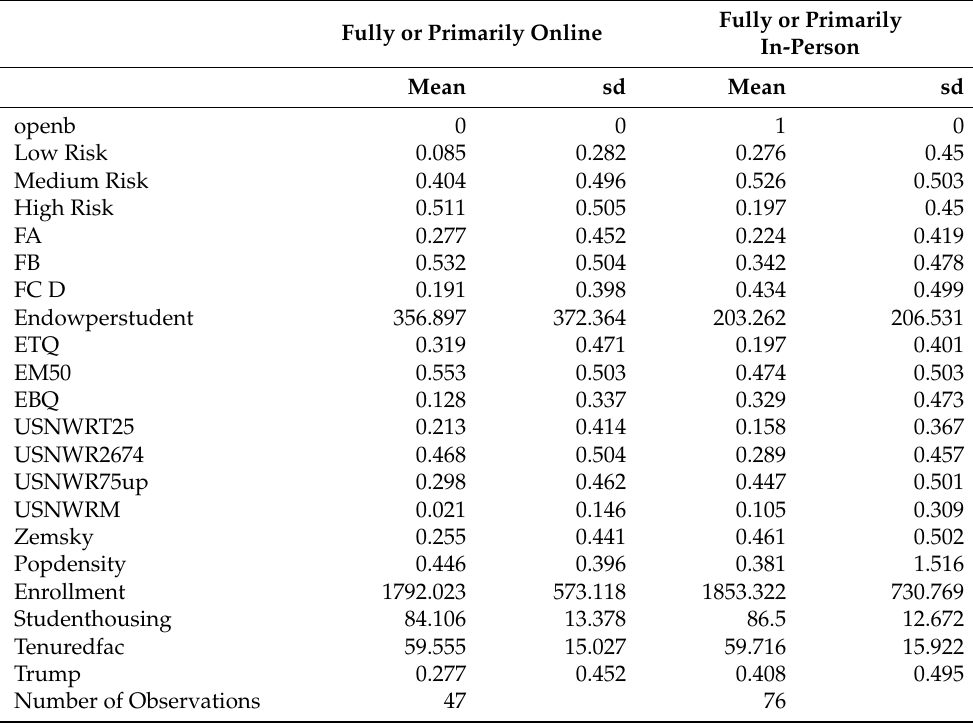
Table 2. Descriptive Statistics: Conditional Means on Openb = 0 or